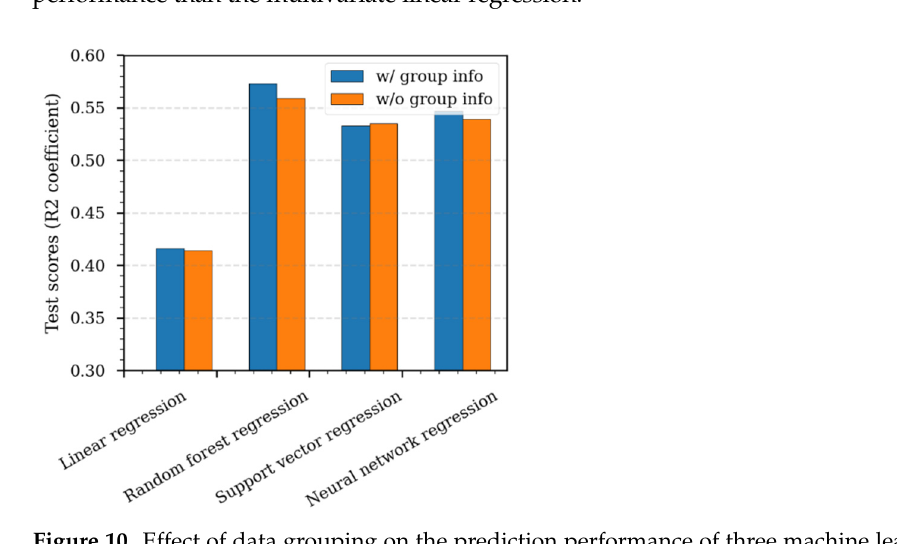
Figure 10. Effect of data grouping on the prediction performance of three machine learning algo- rithms.